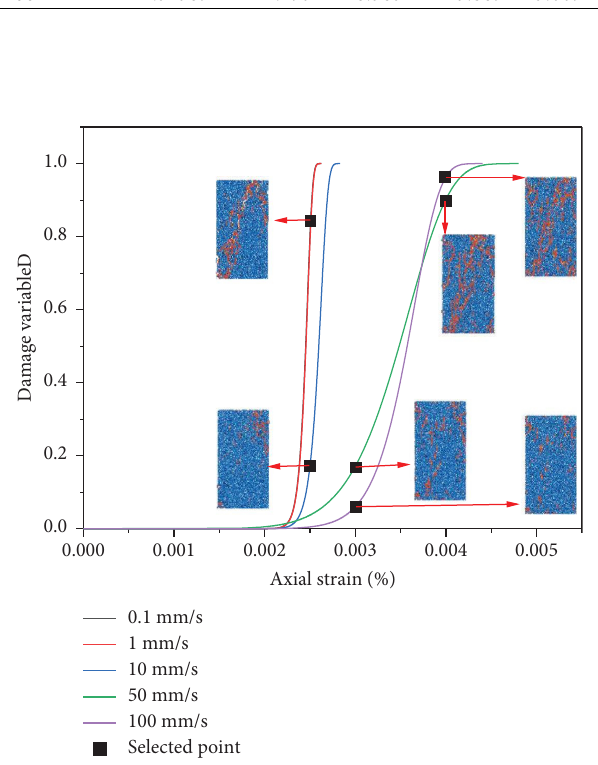
Figure 11: Damage variables and strain rates at diferent loading